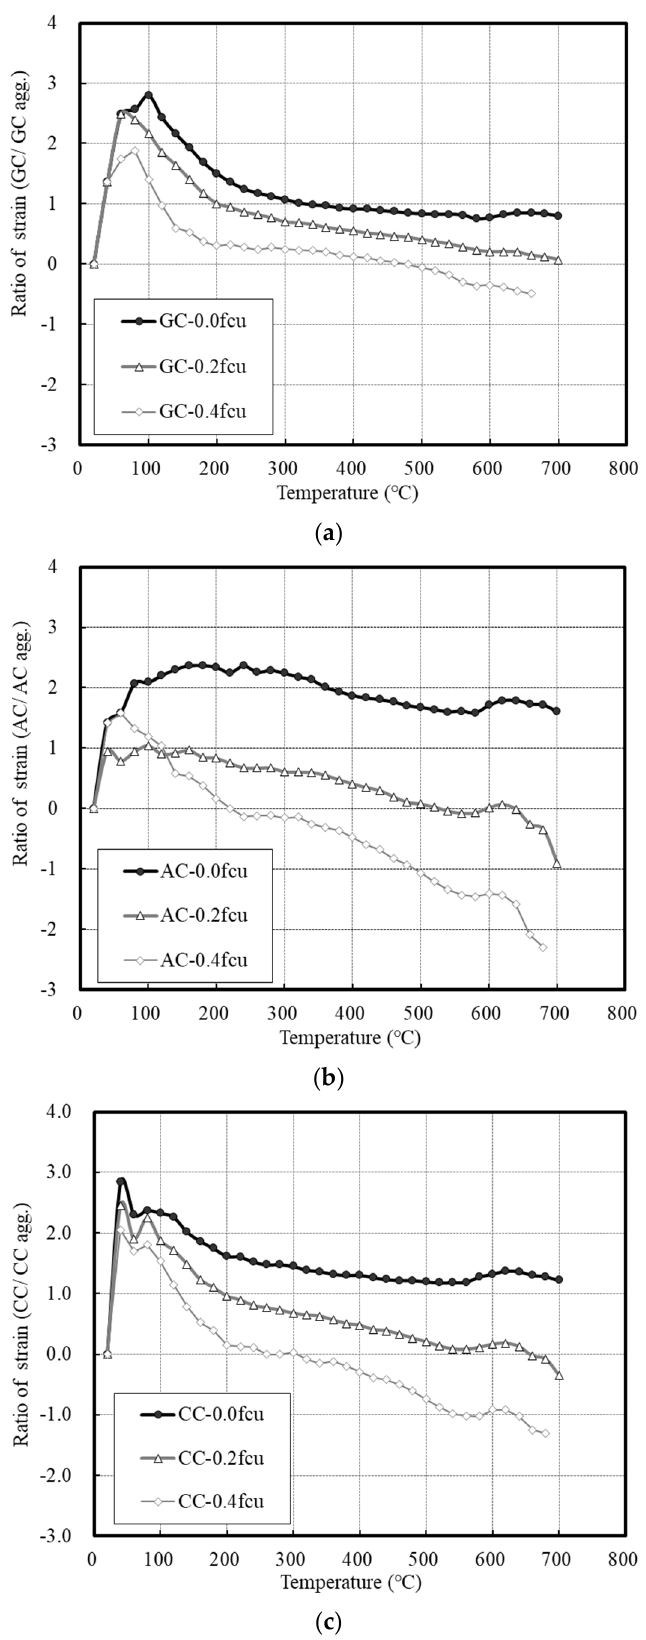
Figure 12. Ratio of strain with heating and loading conditions. ( a ) GC. ( b ) AC. ( c ) CC.